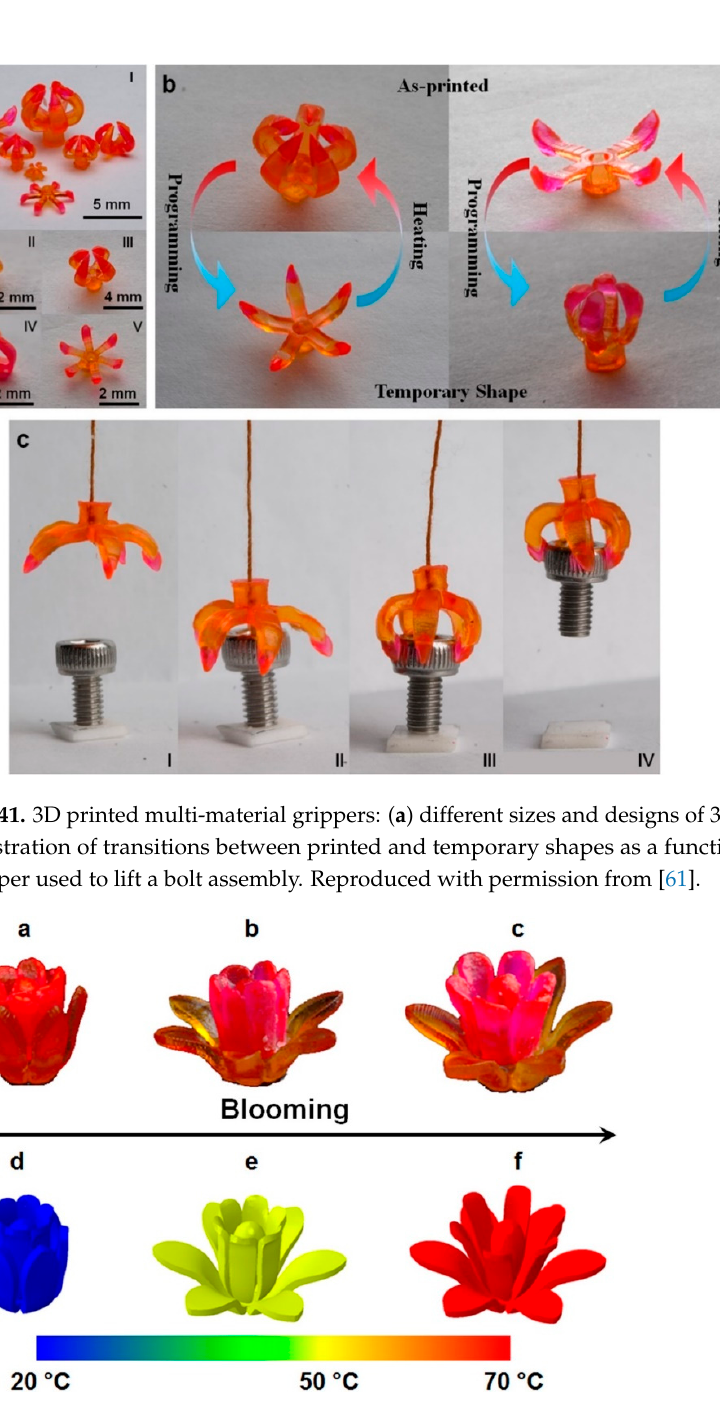
Figure 42. Stimuli-responsive behavior of a multi-material 3D printed flower: ( a ) Programmed (temporary) shape of the multi-material flower held at 20 °C; ( b ) heating to 50 °C, resulting in the flower’s outer buds opening; ( c ) the flower fully bloomed at 70 °C; ( d – f ) simulation images of the complete multi-material flower blooming process. Reproduced with permission from [61].